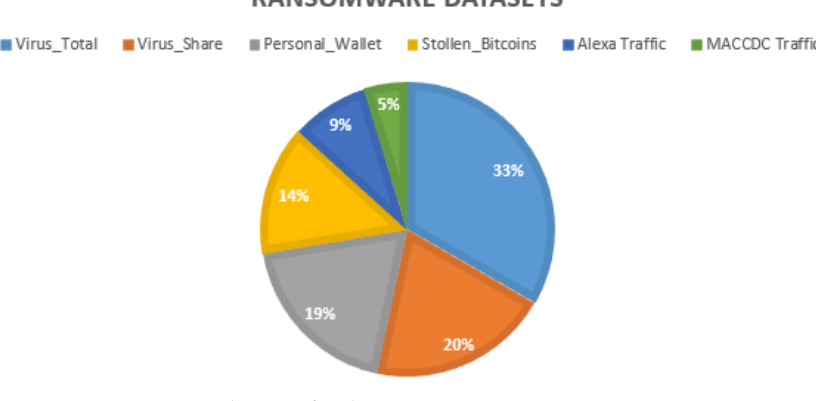
Figure 8. Ransomware datasets for the